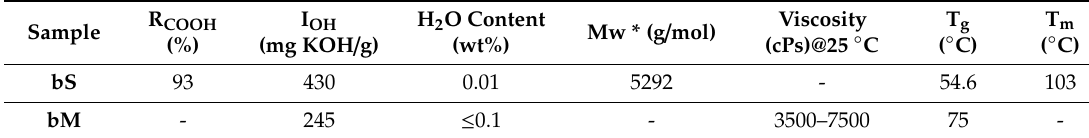
Table 3. Characteristics of bS and bM polyols.